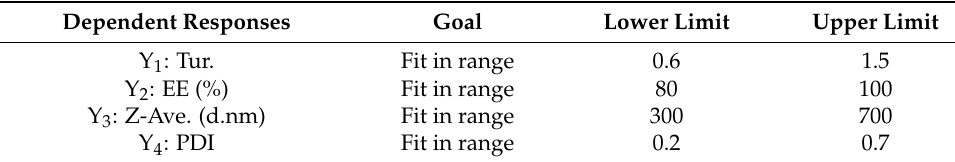
Table 4. Desired ranges of dependent responses.